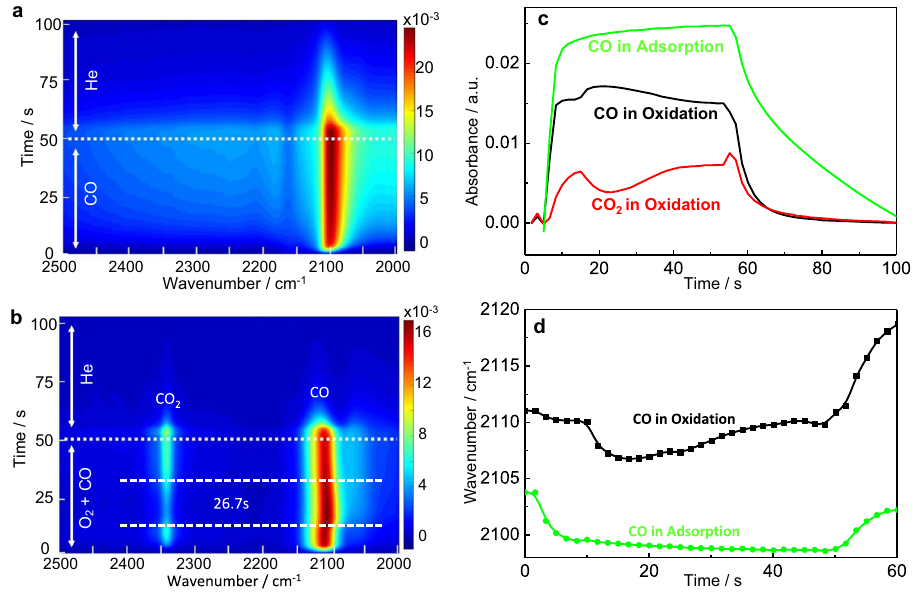
Fig. 1 | FTIR spectra of CO adsorption and CO oxidation on Au/TiO 2 at 25°C. a CO adsorption; b CO oxidation. Plots of CO and CO 2 band intensity against time ( c )andplotoftheCOstretchingbandmaximumagainsttime( d )foranexperiment at 25°C. Experimental conditions: Flow rate is 30mLmin − 1 ; modulation period is 100s; number of spectra in one cycle is 60. For CO adsorption, during the fi rst